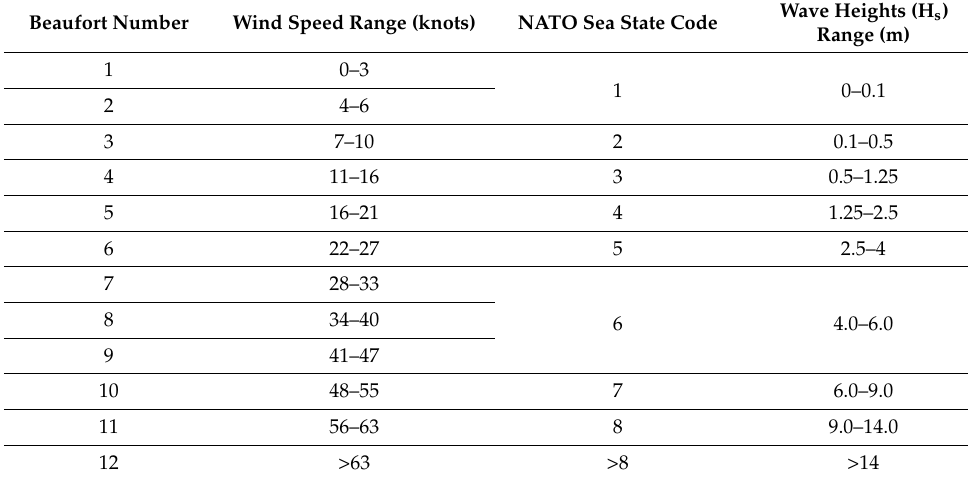
Table 10. These a cg values are directly utilised in the model as an input as can be seen in Figure 4. Table 9. Sea state specifications [26].